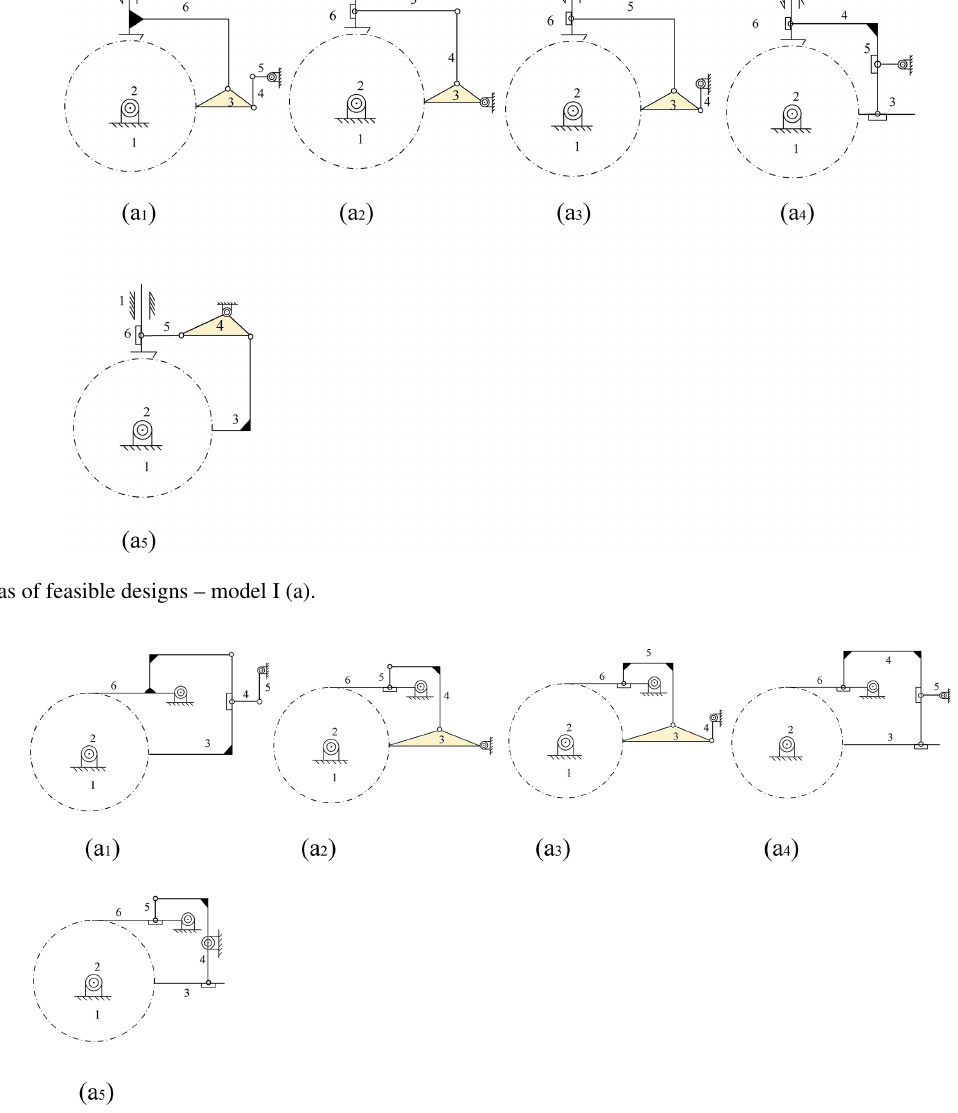
Figure 15. Atlas of feasible designs – model I